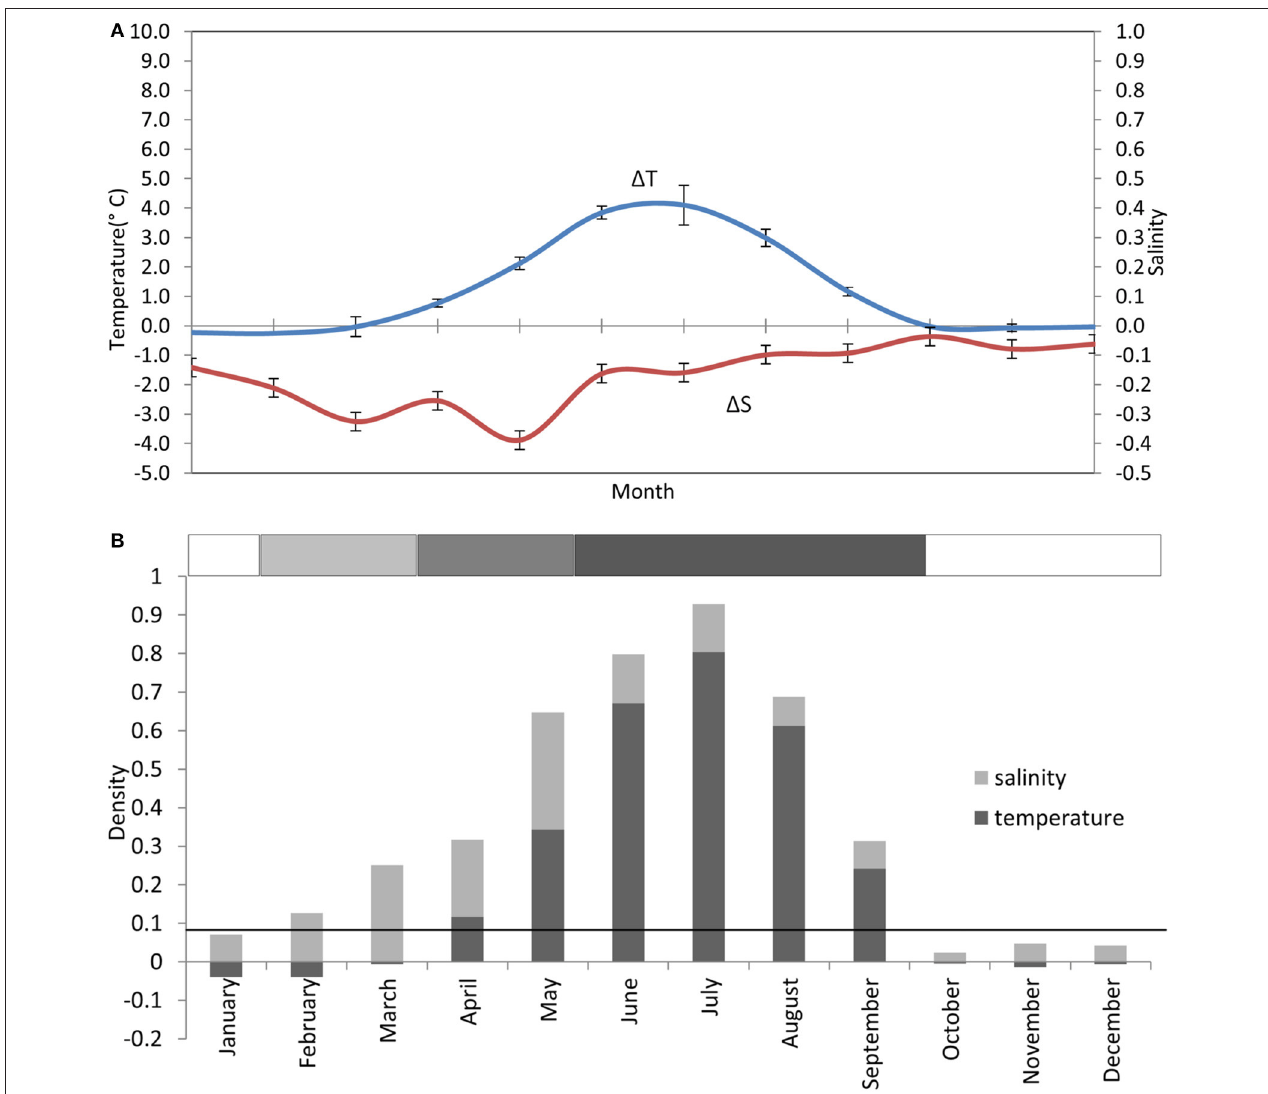
FIGURE 3 | Stratification climatology taken from monthly CTD profiles at the AFBI mooring site 38A in the WIS over a 10 year period (2005–2014). (A) Near-surface to near-seabed differences in temperature ( ◦ C) ( ± StDev) and salinity ( ± StDev), scaled to show their contribution to density layering. (B) Contributions of the temperature and salinity differences to the density layering in each month. The solid horizontal black line indicates where the near-bed density exceeds the near-surface density by 0.086 kgm − 3 . The horizontal bar on top of (B) is the stratification bar, where white, no stratification; light gray, haline stratification; medium gray, haline + thermal stratification; and dark gray, thermal